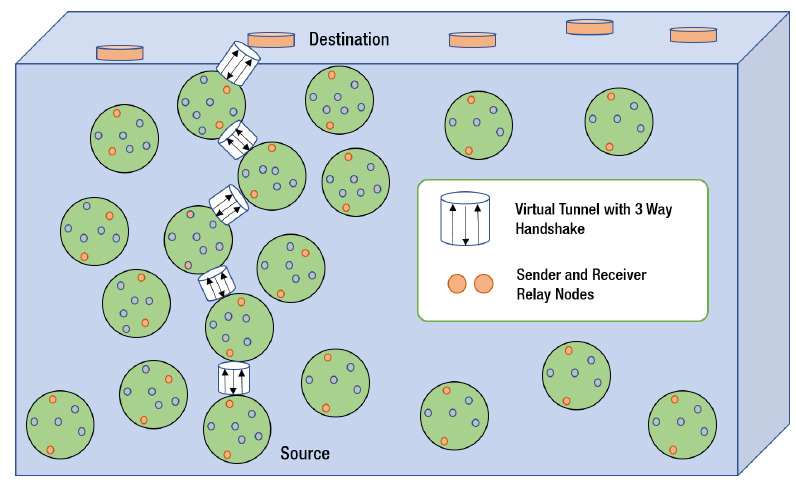
Figure 6. Data transmission in Virtual Tunneling Protocol (VTP)